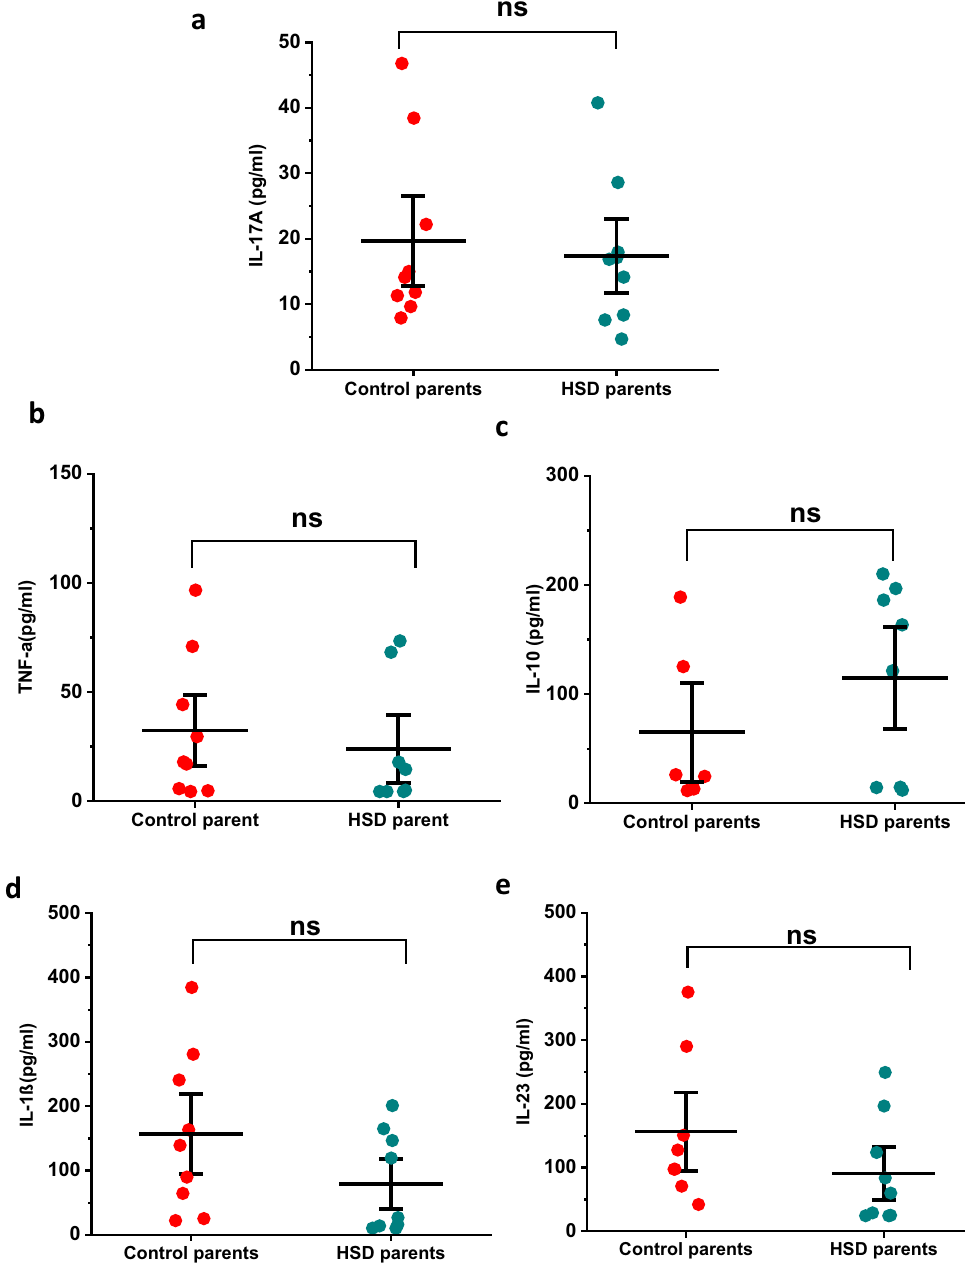
Figure 4. HSD does not change serum concentration of proinflammatory cytokines in female parental mice. Serum concentration on proinflammatory cytokines were measured using flow cytometry-based assay after offspring weaning. ( a , b ) Samples from HSD-fed female mice showed no change in the concentration of proinflammatory cytokines IL-17 (n = 9 in control and HSD-fed group) and TNF-α (n = 9 in control and n = 8 in HSD-fed group), or the ( c ) anti-inflammatory cytokine IL-10 (n = 6 control, n = 8 HSD-fed). ( d , e ) Proinflammatory cytokines IL-1β (d, n = 9 in control and HSD-fed group) and IL-23 ( e , n = 8 in control and n = 9 in HSD-fed group) were not significantly reduced in HSD-fed females (n = 5 and n = 4 control, 5 HSD). Data are described as mean ±